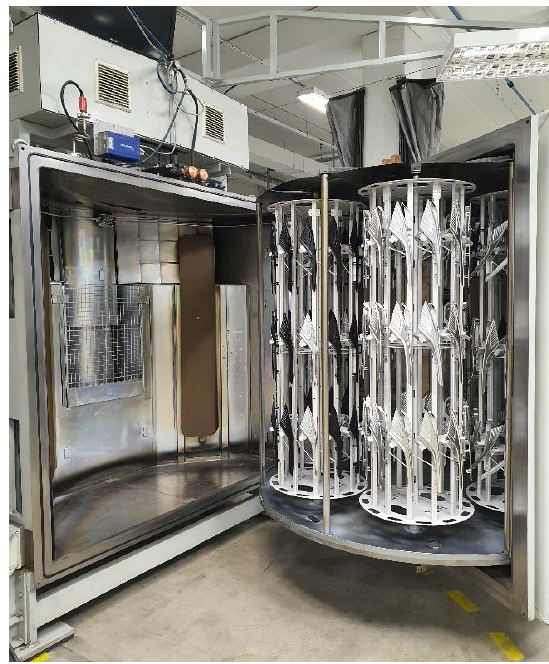
Figure 7. A photo of the fully loaded chamber with samples mounted on planetaria.